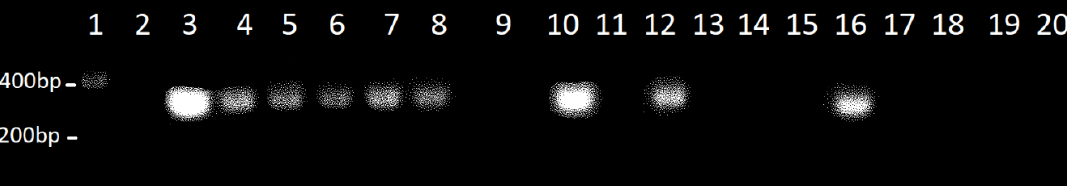
Figure 5. Helper Vero cells expressing viral pA104R. ( A ) Immunofluorescence studies detected African swine fever virus (ASFV)-pA104R in the cytoplasm and nucleus of Vero-pA104R cells. pA104R and DAPI (4′,6-diamidino-2-phenylindole) staining is shown in green and blue, respectively. ( B ) Transformed Vero cells non-infected and infected with Ba71V isolate (multiplicities of infection (MOI) = 2; 18 h post infection (hpi)) were re-suspended into buffer containing 0.1% Tx-100 and fractionated. pA104R was only detected in the Triton X-100-insoluble fraction, as expected, both in non-infected and infected transfected cells. β-actin was used as loading control.